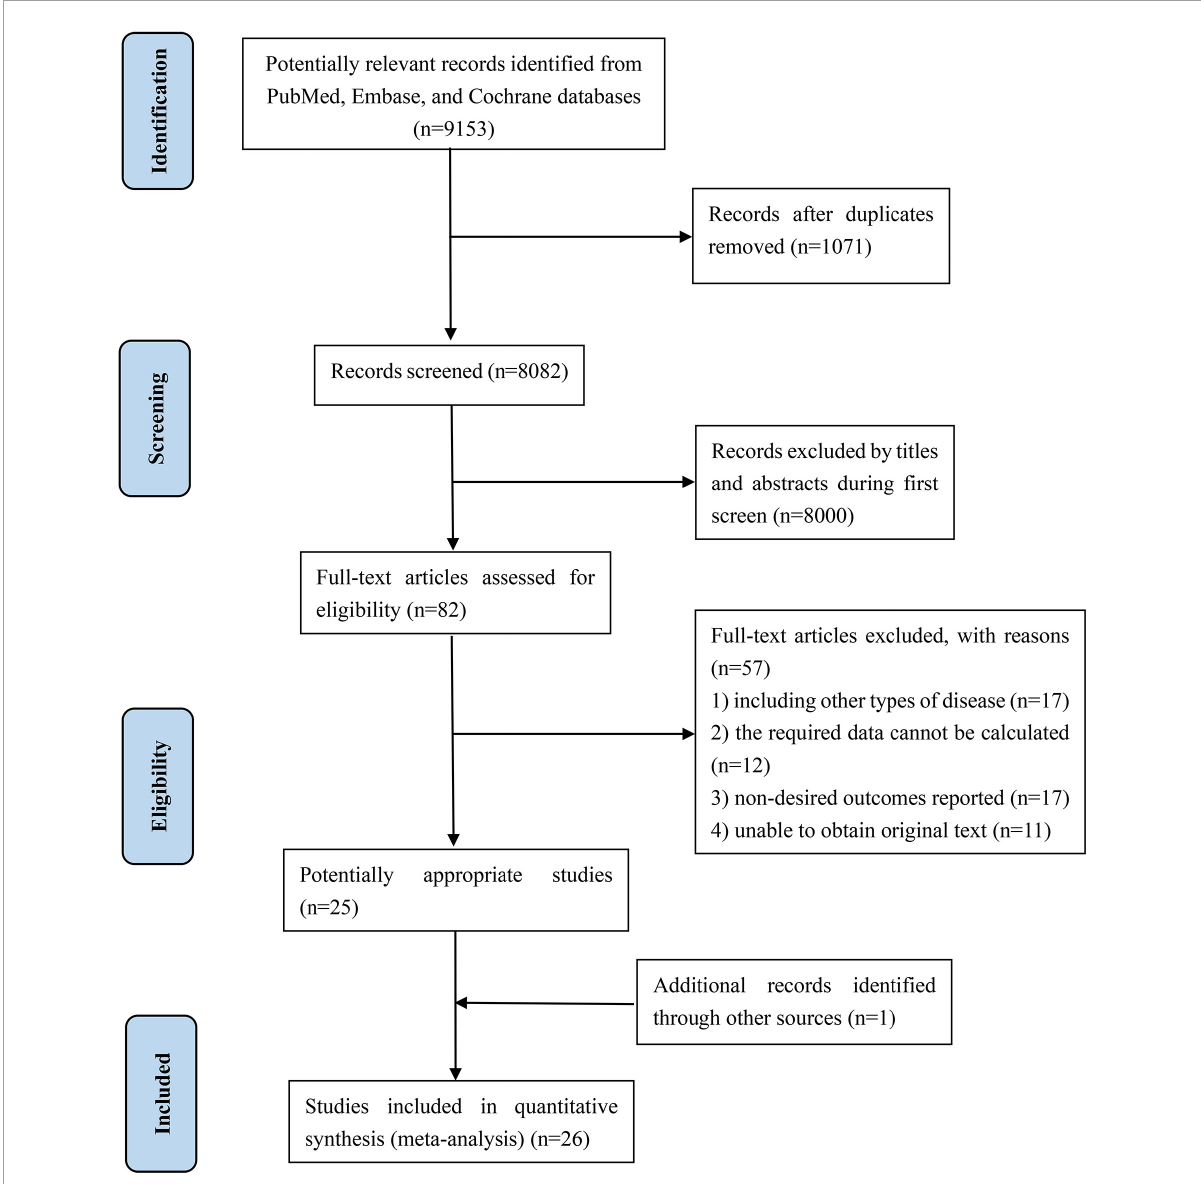
FIGURE1 Flowchart for searching and selection